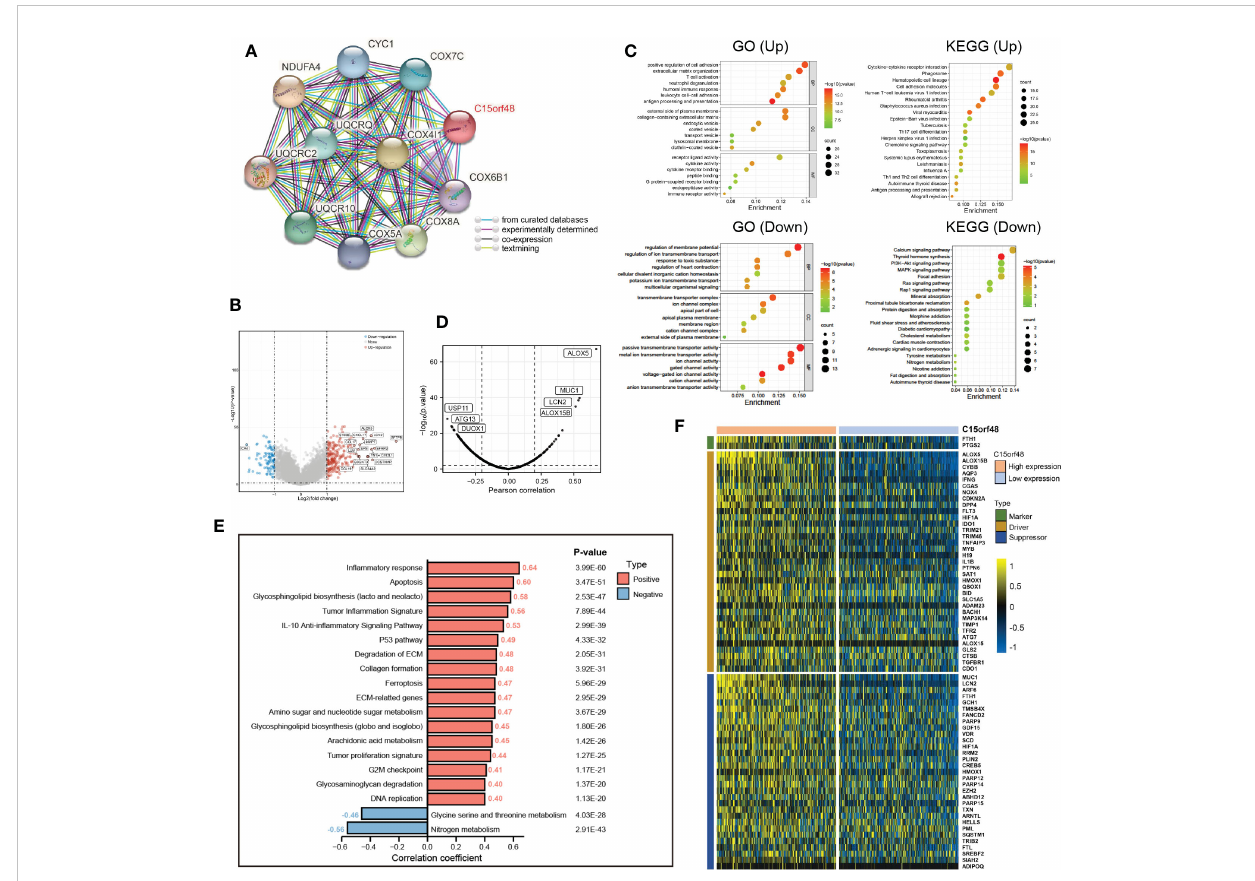
FIGURE 6 (A) The protein interaction network of C15orf48; (B) Volcano map of differential genes in C15orf48 high and low expression groups; (C) GO and KEGG functional enrichment analysis; (D) Correlation between C15orf48 and ferroptosis-related genes in THCA; (E) Correlation between C15orf48 and some pathways in THCA; (F) Expression of ferroptosis-related genes positively correlated with C15orf48 in